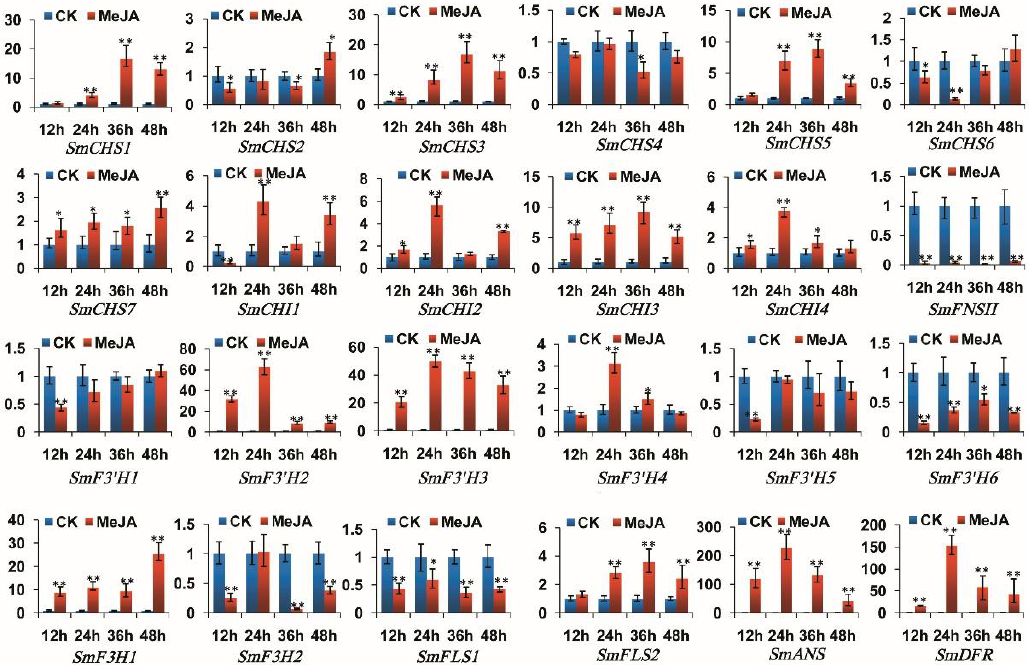
Figure 8. Expression of flavonoid biosynthesis-related genes in roots of S. miltiorrhiza treated with MeJA for 12 h, 24 h, 36 h and 48 h. The levels of transcripts were analyzed using the qRT-PCR method. p < 0.05 (*) and p < 0.01 (**) were considered statistically significant and extremely significant, respectively.